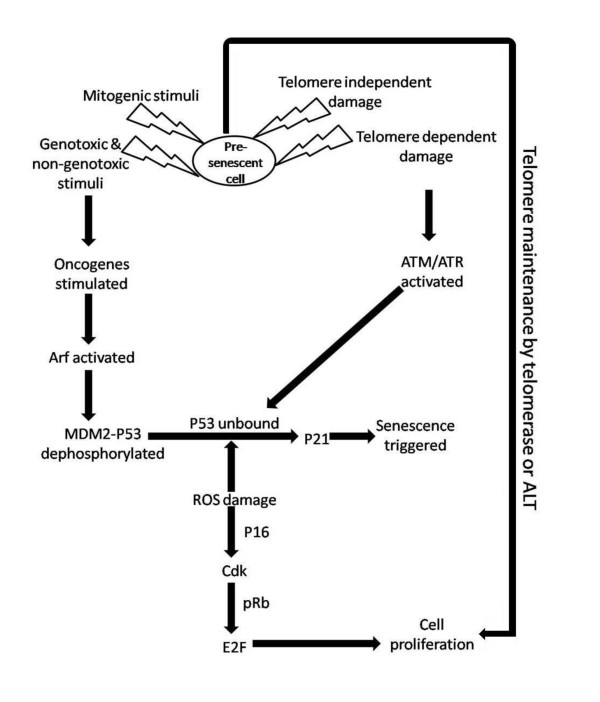
Prerequisites for the onset of neosis and step-wise depiction of primary neosis (P/neosis) and secondary and tertiary neosis (S/T neosis). When a normal diploid cell accumulates genetic mutation owing to exposure, either dies following apoptosis or necrosis or may enter mitotic crisis and after repair again re-enters cell cycle or may become tetraploid after few hours or become polyploidy and succumb to senescence or may circumvent senescence and divide by neosis. Neosis of non-viable NMCs may give rise to genetically viable daughter cells 'Raju cells' by P/neosis and further divide and re-divide by S/T neosis. The number of progenies may vary from one to infinite and differ from NMCs and other daughter cells unlike conventional mode of division, mitosis. Number of surviving progenies depends on the 'survival of the fittest'.